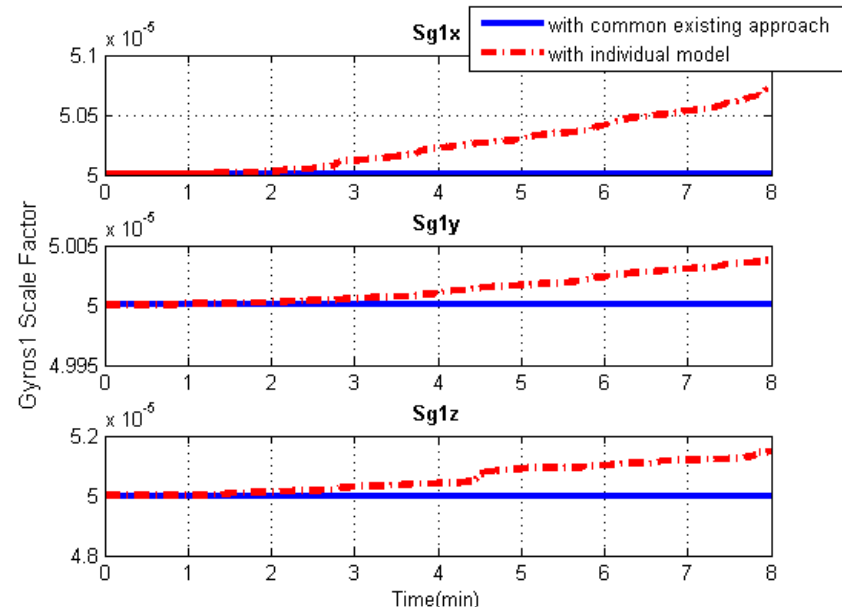
Figure 14. Gyroscope scale factor solution comparisons of the central IMU using the common existing approach or the individual modeling method.